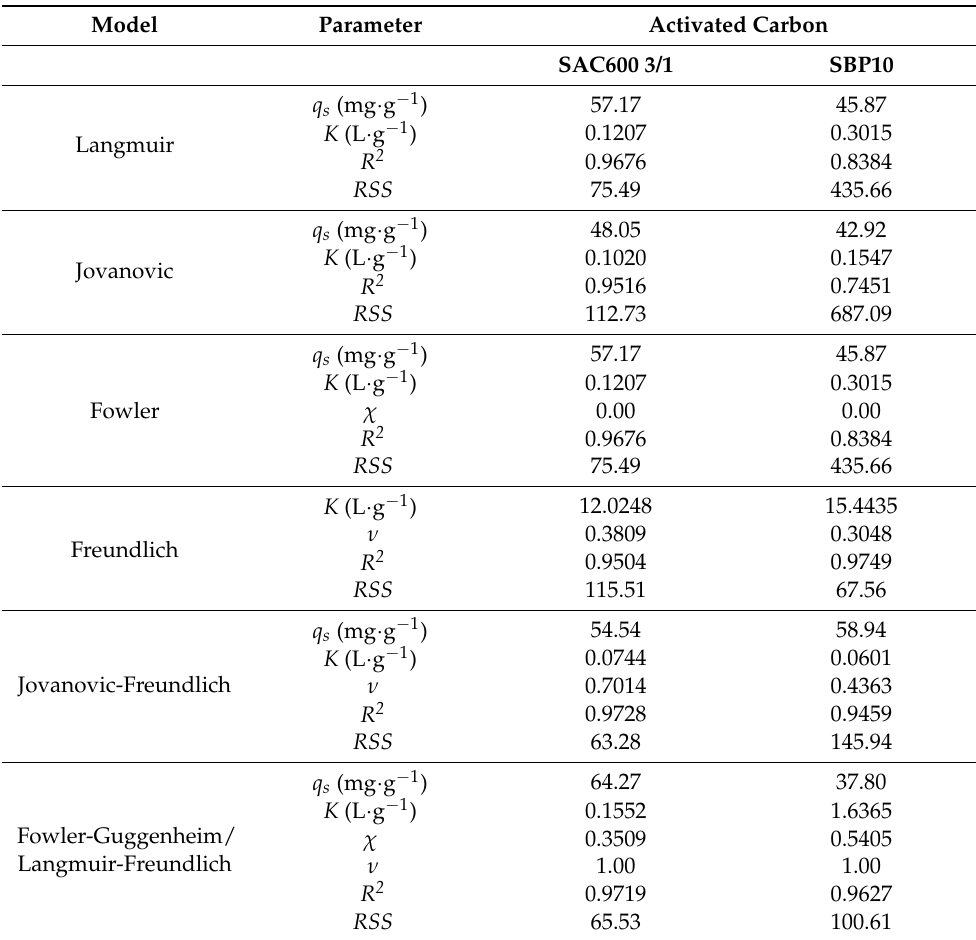
Table 7. Adsorption isotherm parameters for SAC600 3/1 and